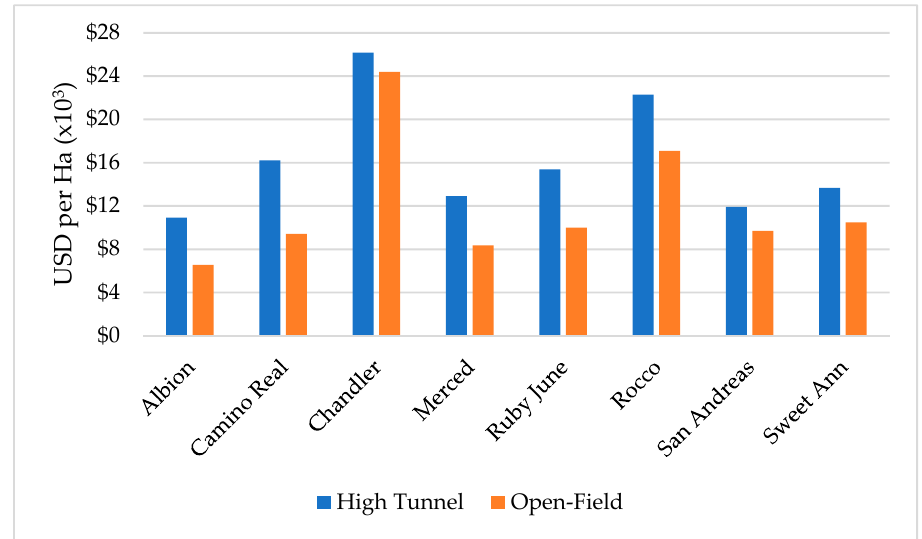
Figure 4. Harvest labor cost in USD per hectare for high tunnel and open-field cultivars and for a pre-pick operation.